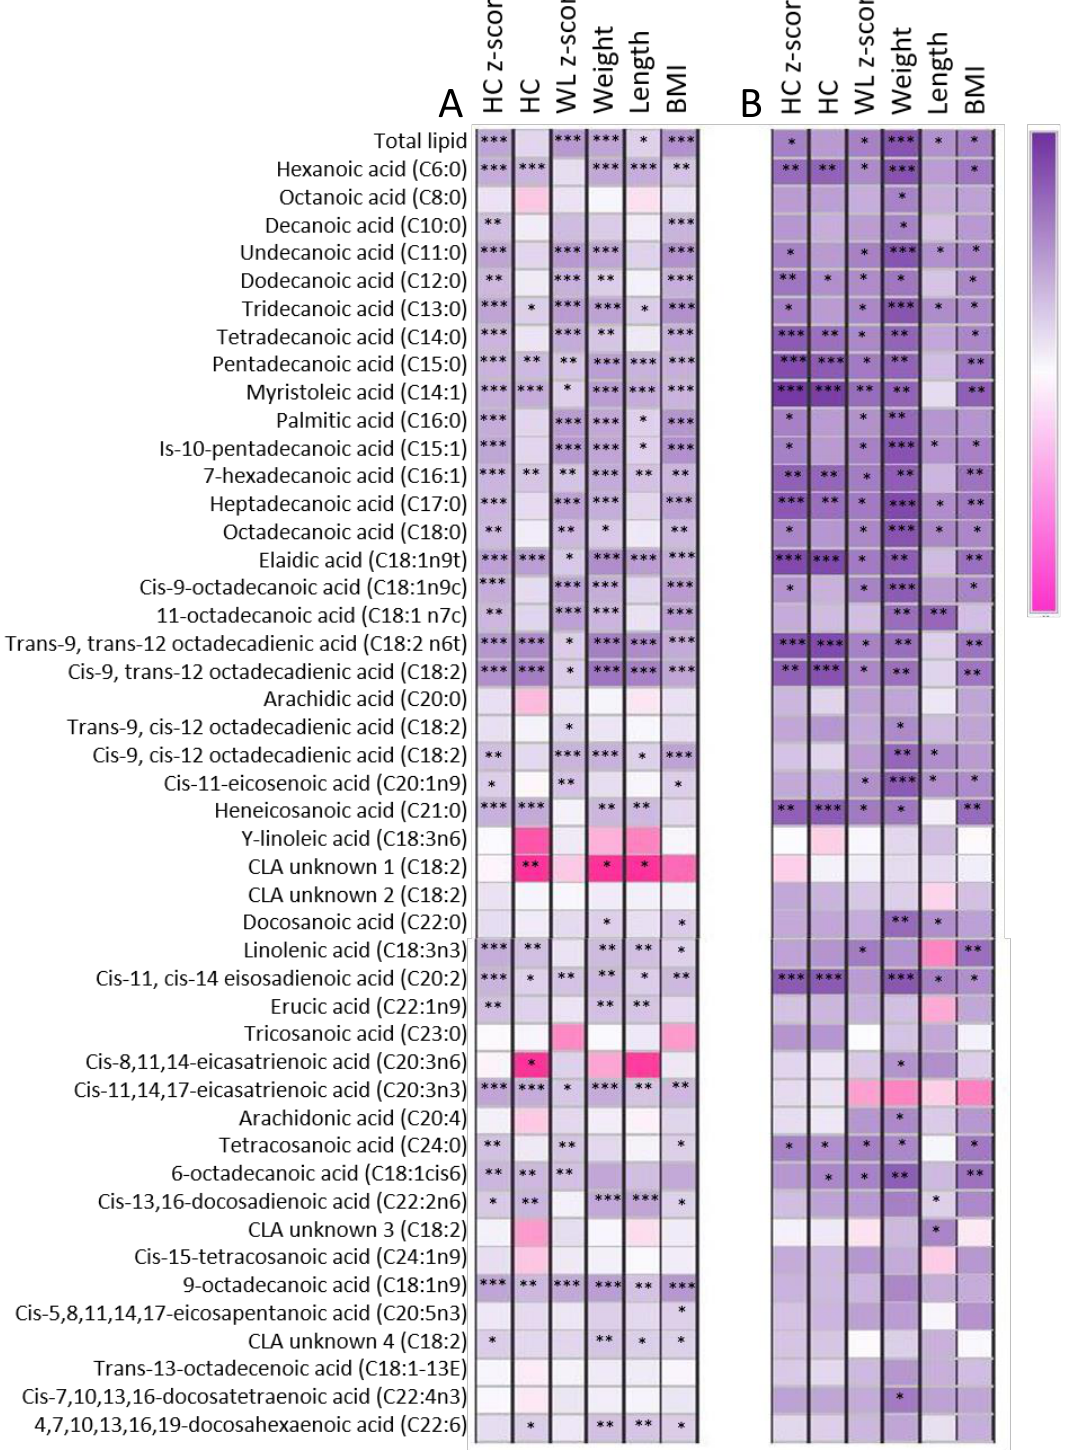
Figure 1. Relationships between infant lipid intake and infant growth characteristics. ( A ) Monthly intake and growth characteristics, ( B ) Mean six-month intake and six-month growth characteristics. Dark purple represents strongest positive correlation, and dark pink represents strongest negative correlation. * Indicates p < 0.05, ** indicates p < 0.01, *** indicates p < 0.001 ( p < 0.001 is significant after accounting for multiple comparisons).